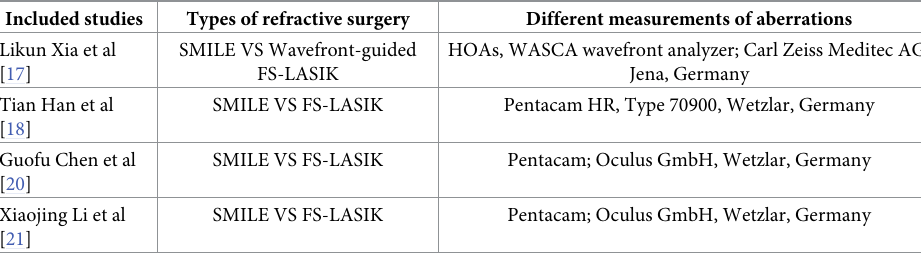
Table 2. Measurement bias of 3 included studies.